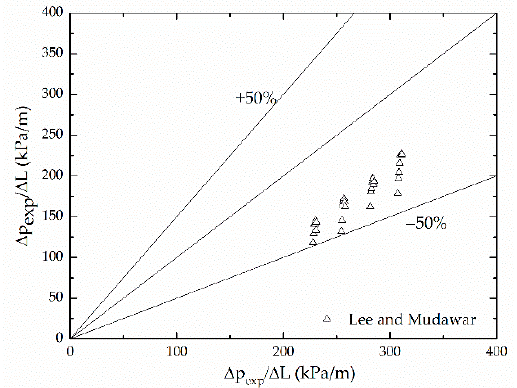
Figure 12. Comparison of new correlation with Lee and Mudawar’s microchannel R-134a data.